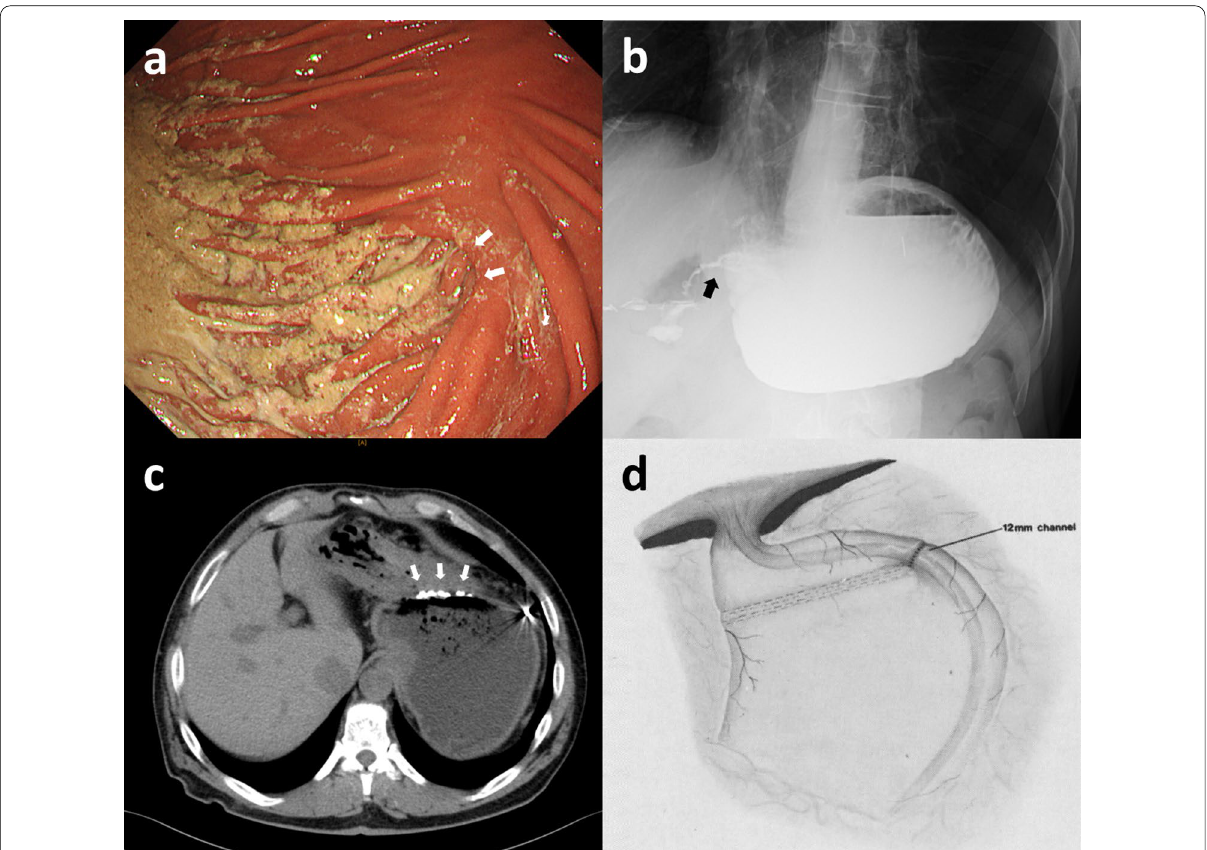
Fig. 1 Preoperative findings. a Esophagogastroduodenoscopy showed a stoma (white arrows) on the greater curvature of the upper gastric body. b Fluoroscopy demonstrated retention of contrast medium in the fundus and poor outflow through the stoma (black arrow). c Abdominal computed tomography revealed a staple line (white arrows) at the upper gastric body and an enlarged fundus filled with food residue. d Complete image of Gomez gastroplasty (reproduced from ref. [4] with permission from